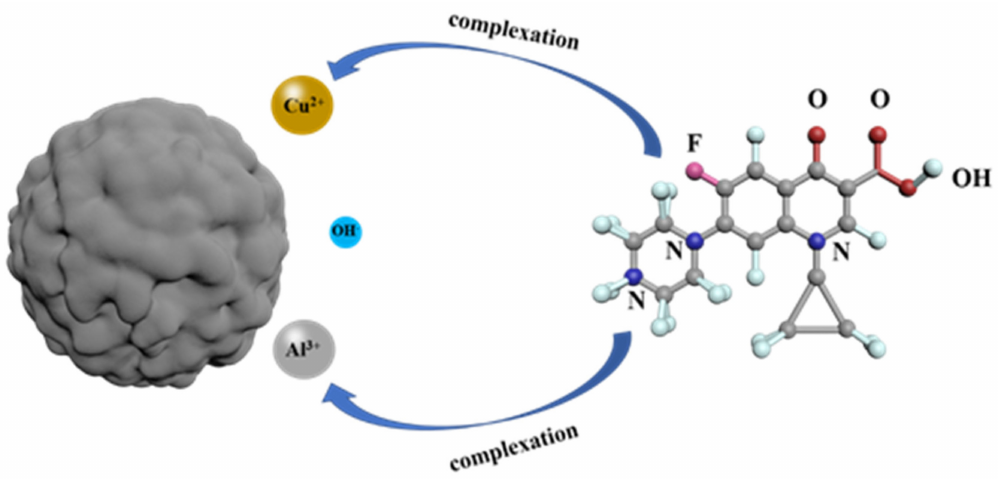
Figure 9. The mechsnism of CIP loaded on